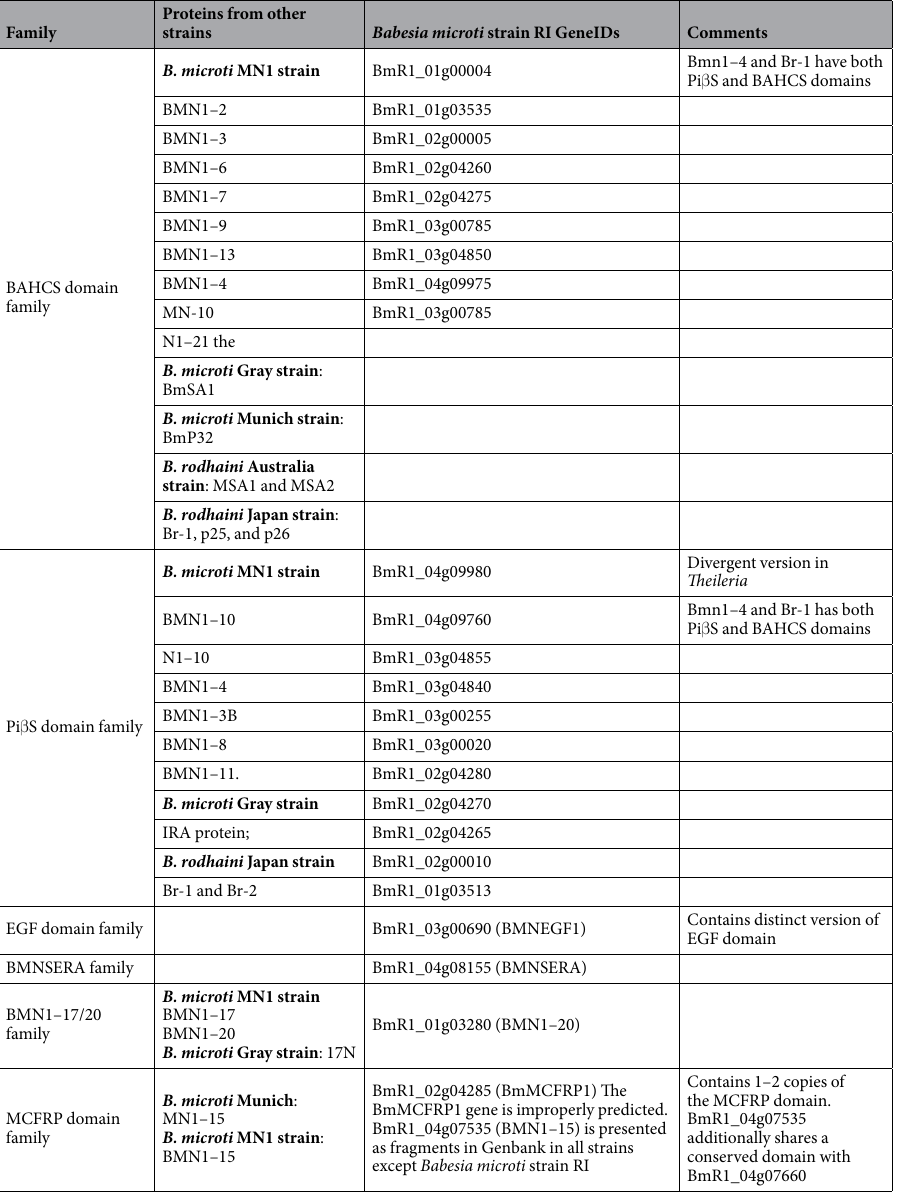
Table 3. Selected families of Babesia microti surface